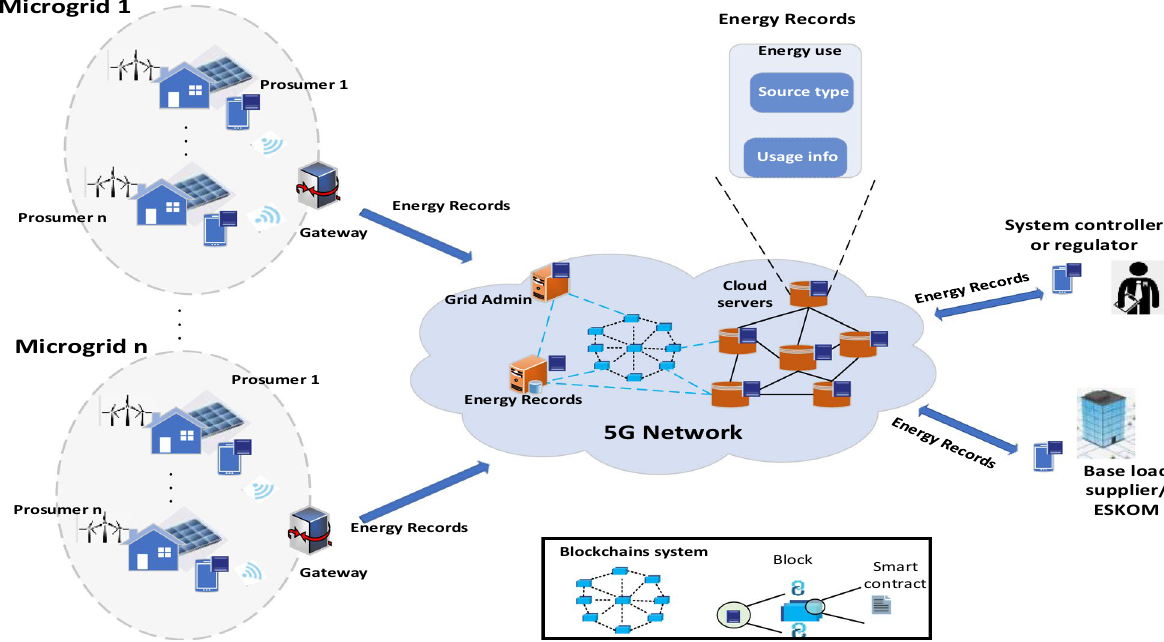
Fig. 2 Blockchain framework for a distributed energy system